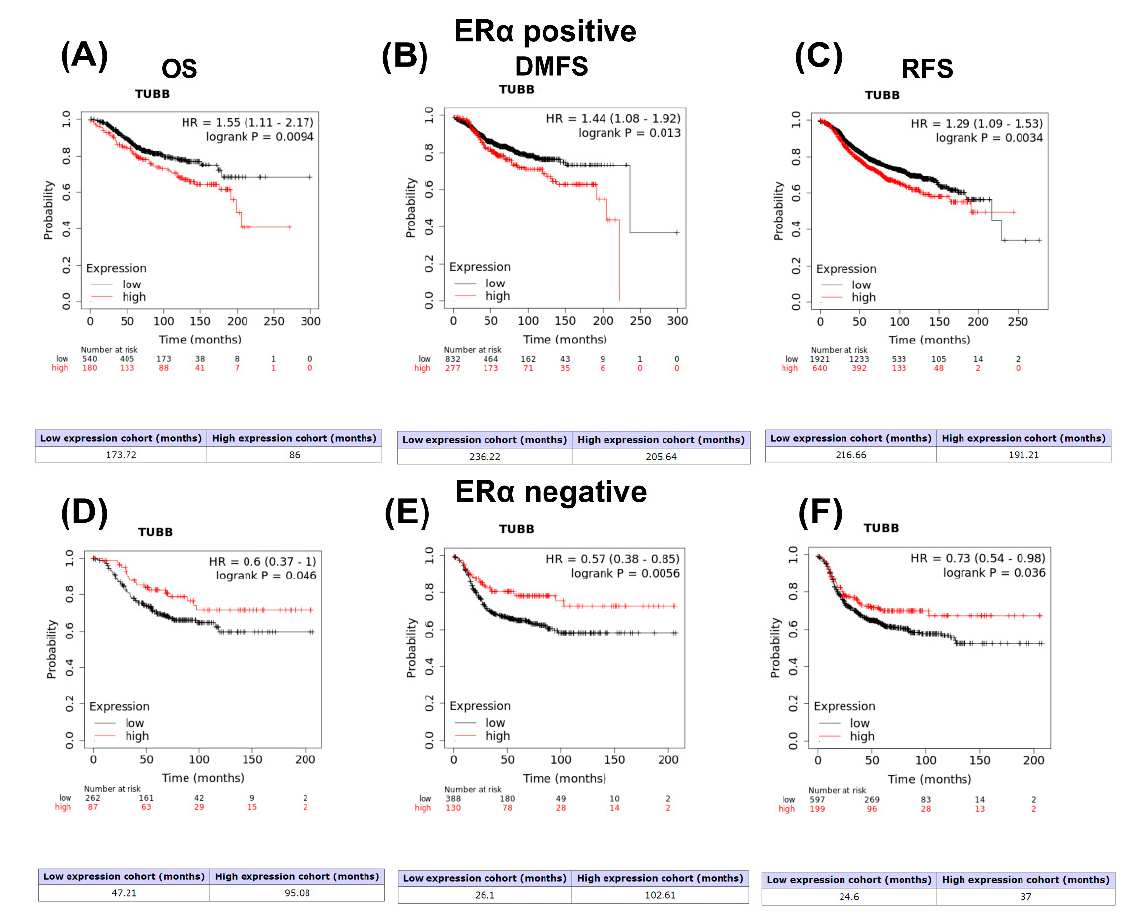
Figure 2. ( A ) Kaplan–Meier curve showing OS of TUBB in ER α –positive breast cancer patients; ( B ) Kaplan–Meier curve showing DMFS of TUBB in ER α –positive breast cancer patients; ( C ) Kaplan–Meier curve showing RFS of TUBB in ER α –positive breast cancer patients; ( D ) Kaplan–Meier curve showing OS of TUBB in ER α –negative breast cancer patients; ( E ) Kaplan–Meier curve showing DMFS of TUBB in ER α –negative breast cancer patients; ( F ) Kaplan–Meier curve showing RFS of TUBB in ER α –negative breast cancer patients.